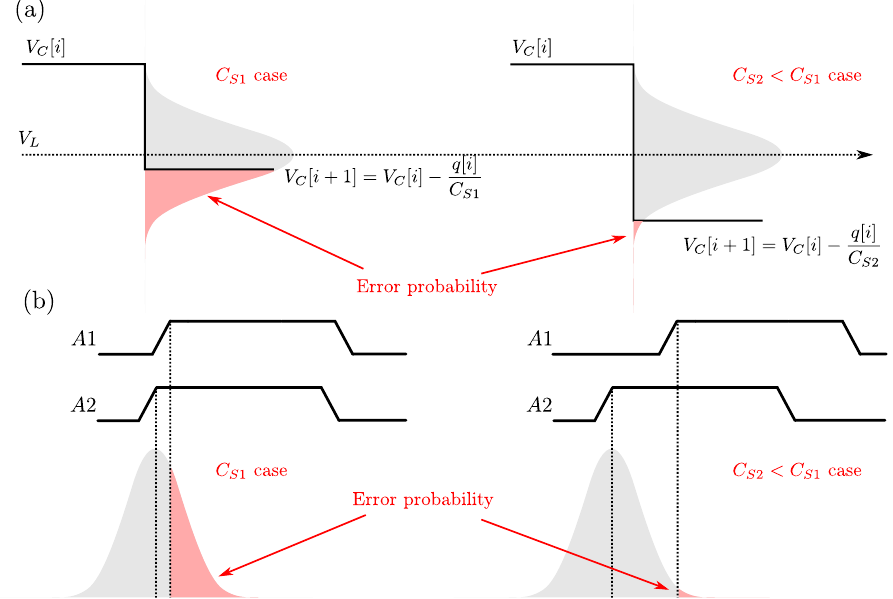
Figure 5. Comparison of comparator noise effects for two different values of C S : ( a ) classic voltage- level based comparator as in Figure 2; ( b ) time-delay comparator of Figure